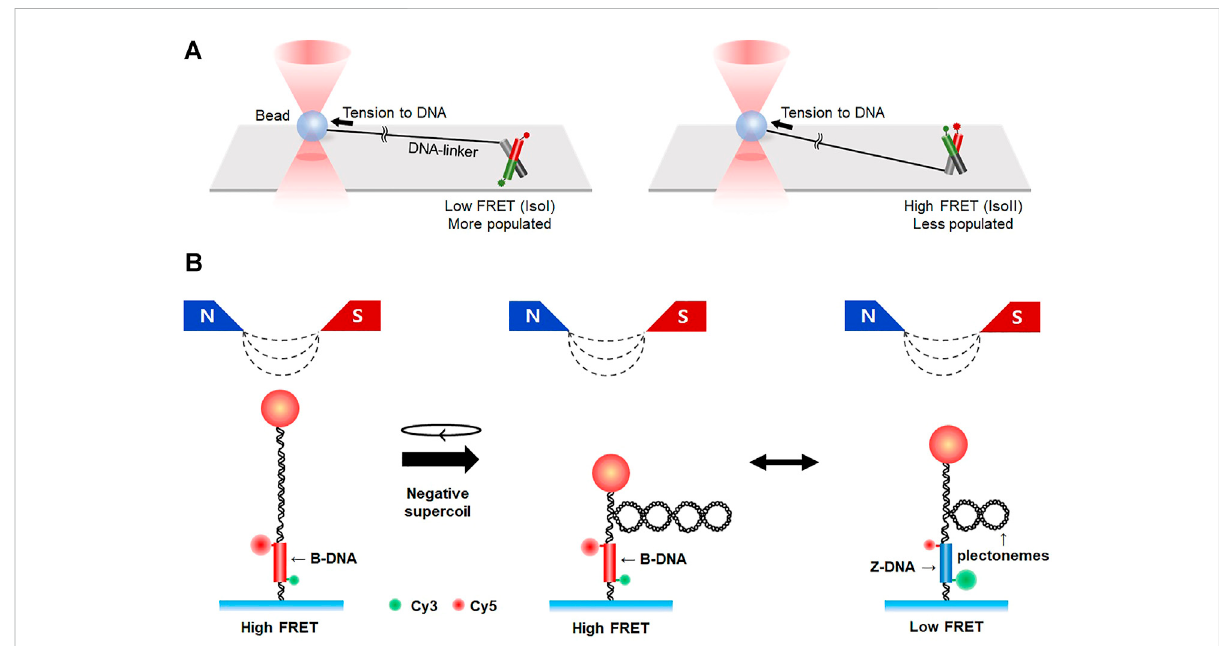
FIGURE 7 Hybrid methods combining single-molecule fl uorescence imaging with force spectroscopy. (A) Integration of smFRET with optical tweezers. Conformational dynamics of HJ are measured by smFRET in the presence of tension, which is exerted to HJ by optical tweezers. Tension to HJ induces a larger population of IsoI conformers (left) than IsoII (right). (B) Hybrid system combining smFRET and magnetic tweezers. Negative supercoilingisapplied to DNAbymagnetic tweezers, resulting intheformation ofplectonemes. WhenB-to Z-transitionoccurs,thenumber of plectonemes is reduced and FRET ef fi ciency changes from high to